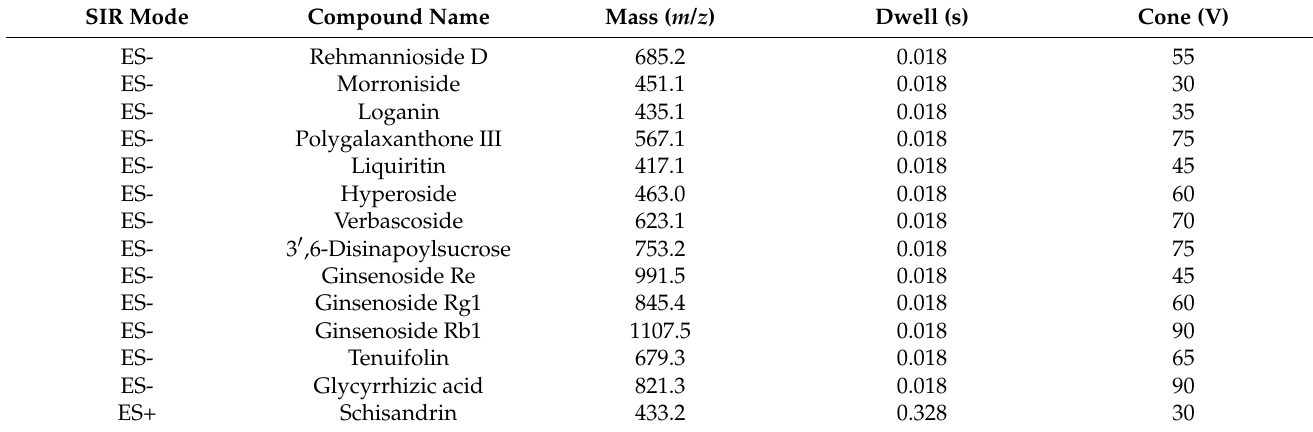
Table 1. Summary of UPLC-MS-SIR mode parameter information for 14